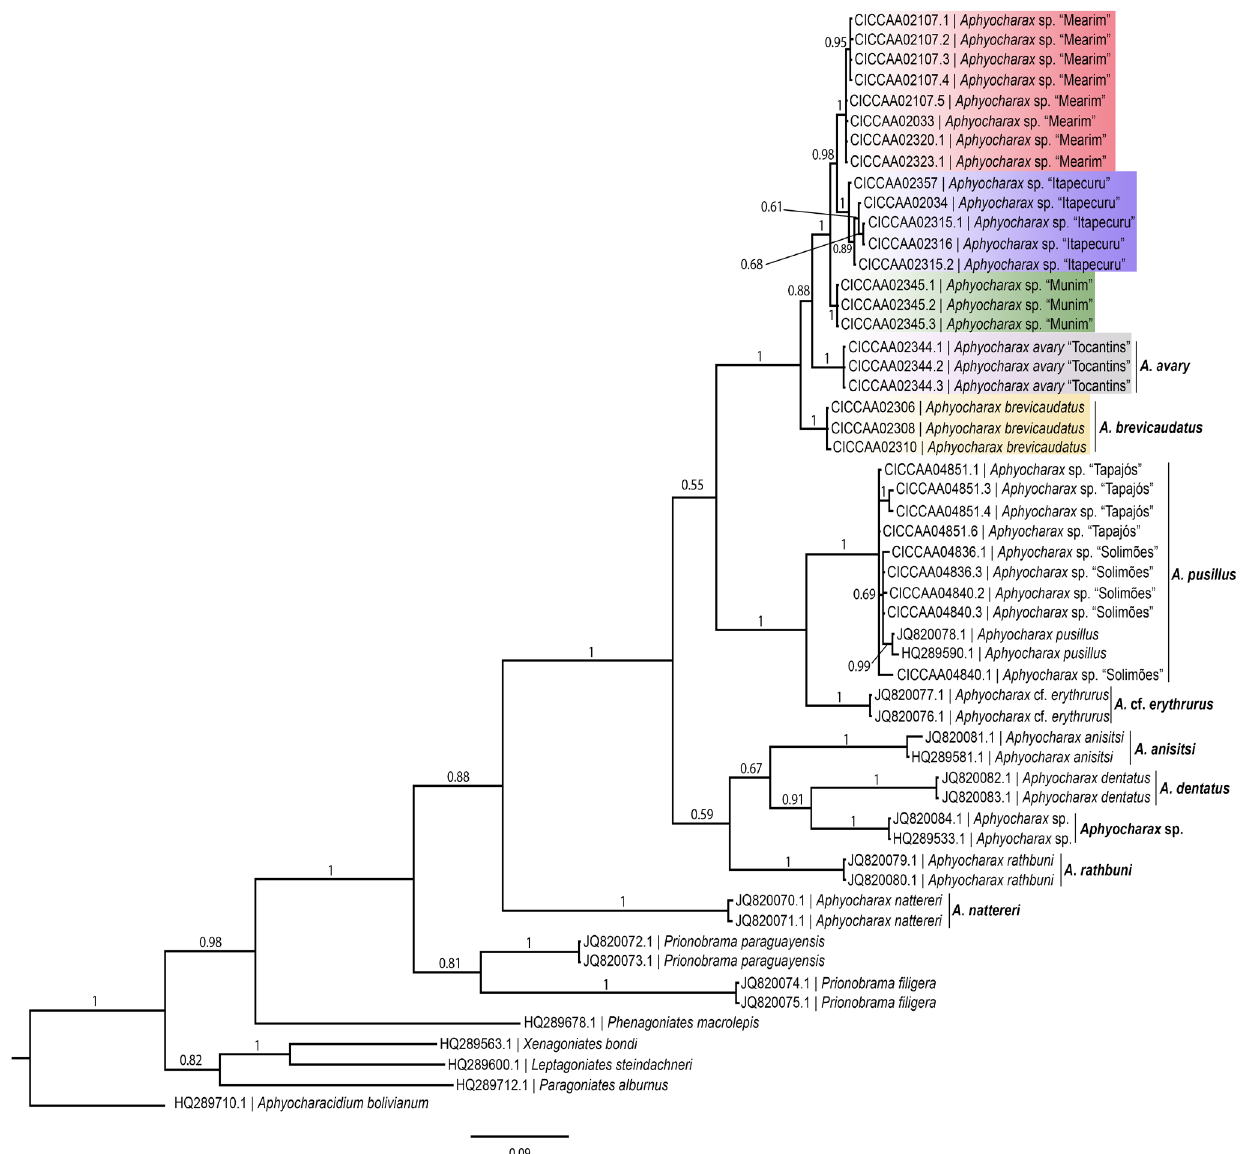
FIGURE 2 | Bayesian inference phylogenetic tree used in the WP species delimitation method. Numbers above and below branches are posterior probability values. The colored haplotypes indicate the ingroup. Each group of haplotypes in the ingroup delimitated by WP as an exclusive lineage (species) has a different coloration. Species delimitated in our ingroup by WP: 1– Aphyocharax brevicaudatus (yellow colored); 2– A . avary (grey colored); 3– A . sp. “Itapecuru” (blue colored); 4– A . sp. “Mearim” (red colored); and 5– A . sp. “Munim” (green